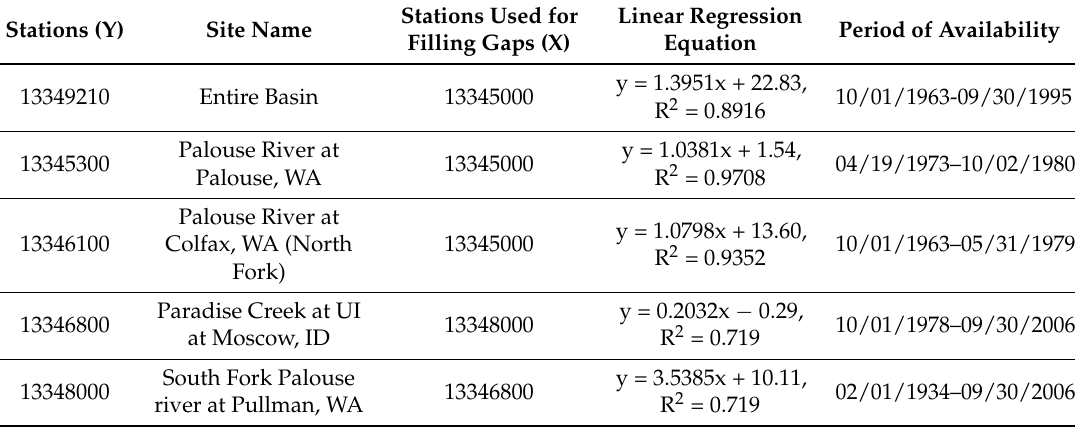
Table 1. Period of Availability of Daily Discharge of USGS Gauging Stations of Palouse